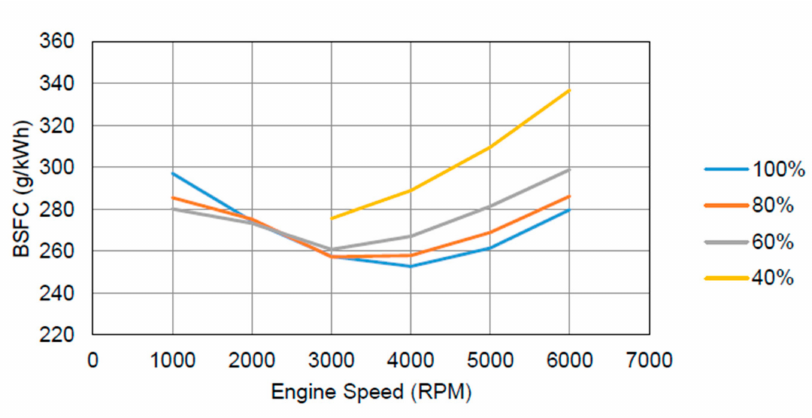
Figure 19. Baseline engine BSFC at di ff erent engine speeds.